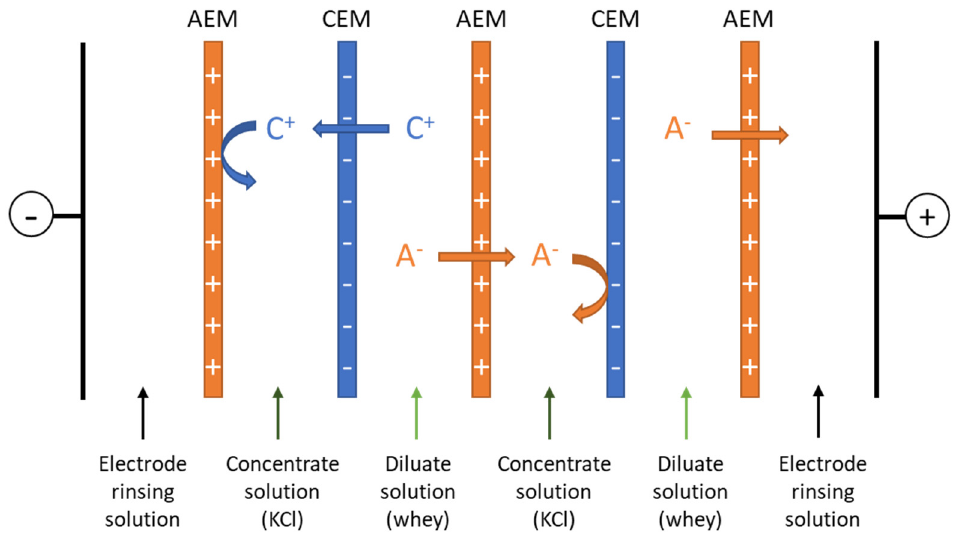
Figure 1. Configuration of the electrodialysis cell used for whey demineralization. C + , cation; A − , anion; AEM, anion-exchange membrane; CEM, cation-exchange membrane.